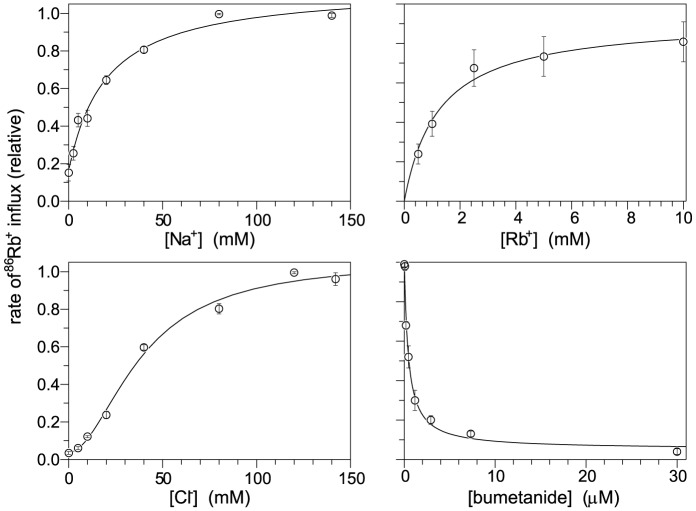
Activity of NKCC1 depends on Na+, Rb+, Cl− and bumetanide concentration.
86Rb influx was determined in HEK cells expressing 3xflag-YFP-tagged hNKCC1 (NT17). Data points are relative to the maximum flux and are the average from three experiments with SEM. Lines are the best fit to a single binding site or in the case of [Cl−] dependence, to the hill equation (n = 1.8). The Km values are (averages of determinations in three experiments): Km(Na) 20.0±2.7 mM, Km(Rb) 1.523±0.40 mM, Km(Cl) 42.8±4.1 mM, and Ki (bumet) 0.46±0.10 µM; these are essentially the same as previously determined for the HA-tagged wild type human NKCC1 [21]: Km(Na) 18.1±1.6 mM, Km(Rb) 1.65±0.16 mM, Km(Cl) 47.9±1.6 mM, and Ki (bumet) 0.42±0.02 µM.